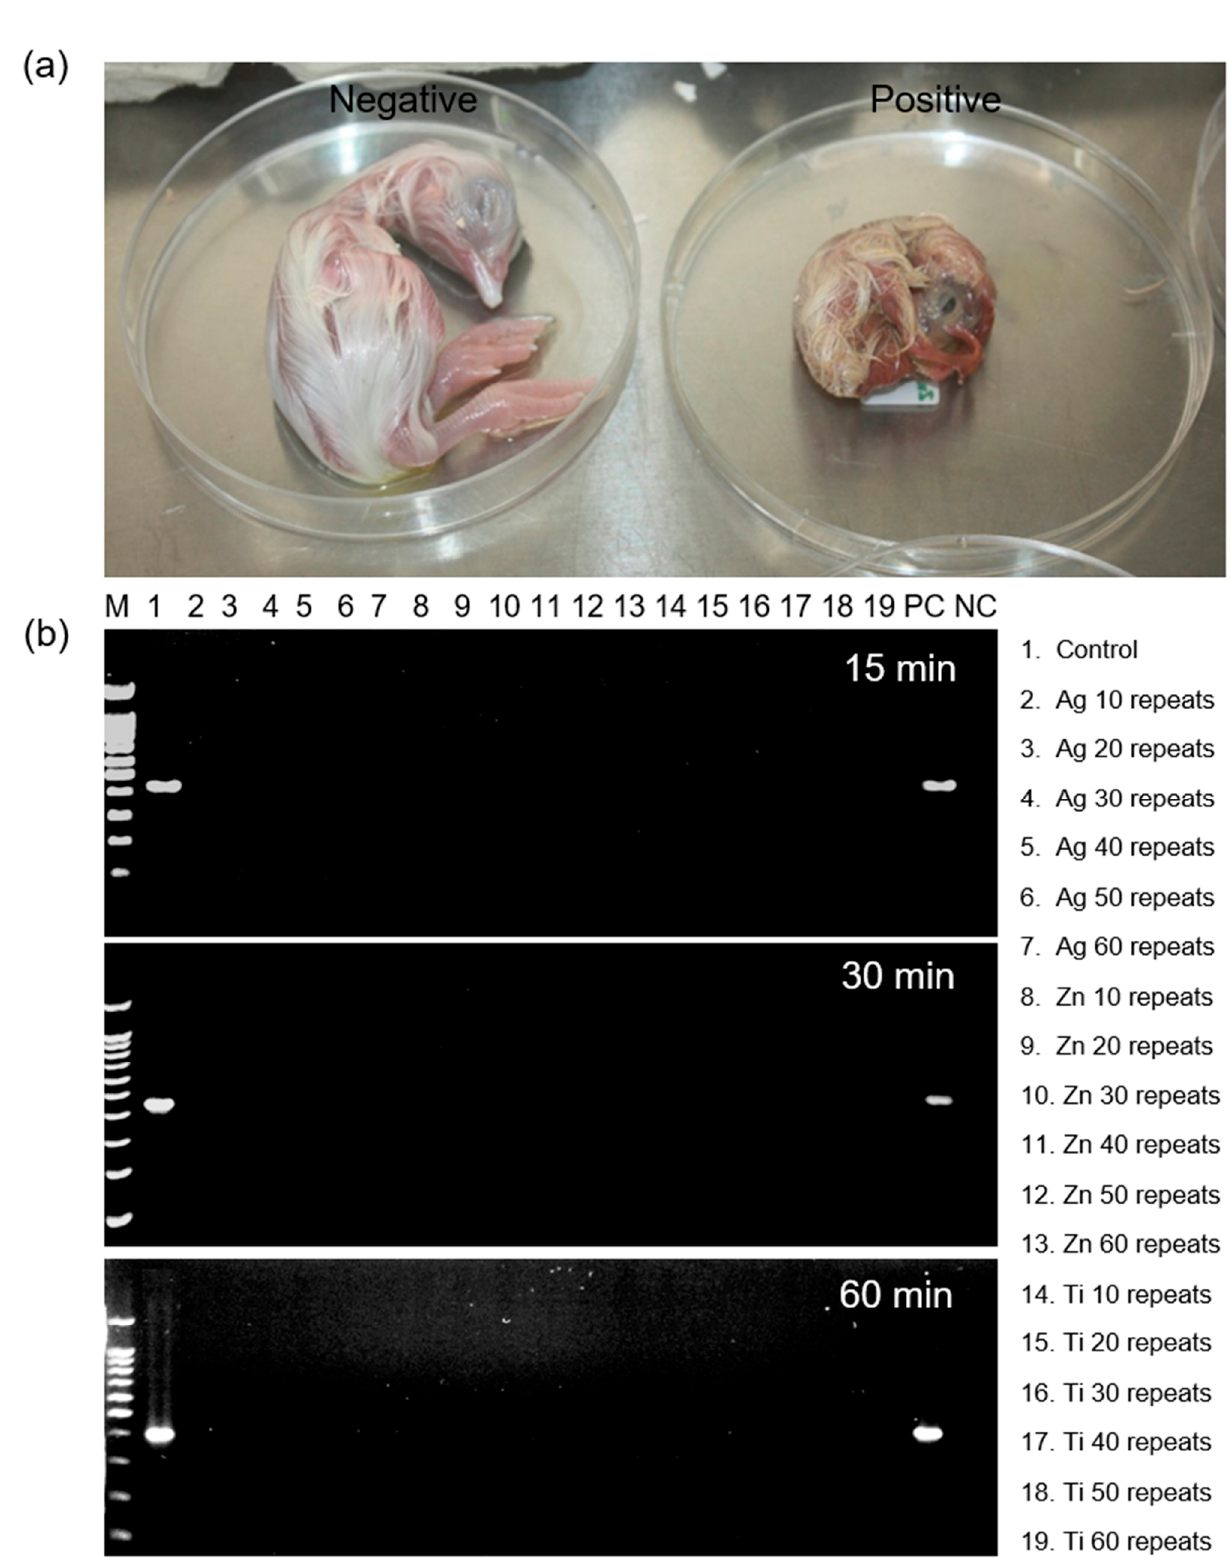
Figure 7. In vivo and in vitro anti-virus properties of the nano-metal-treated PET films: ( a ) Infected embryonic chick images of virus sensitivity showing signs of disease and ( b ) Infectious bronchitis virus amplification of the metal-nano treated PET films (60 repeats).